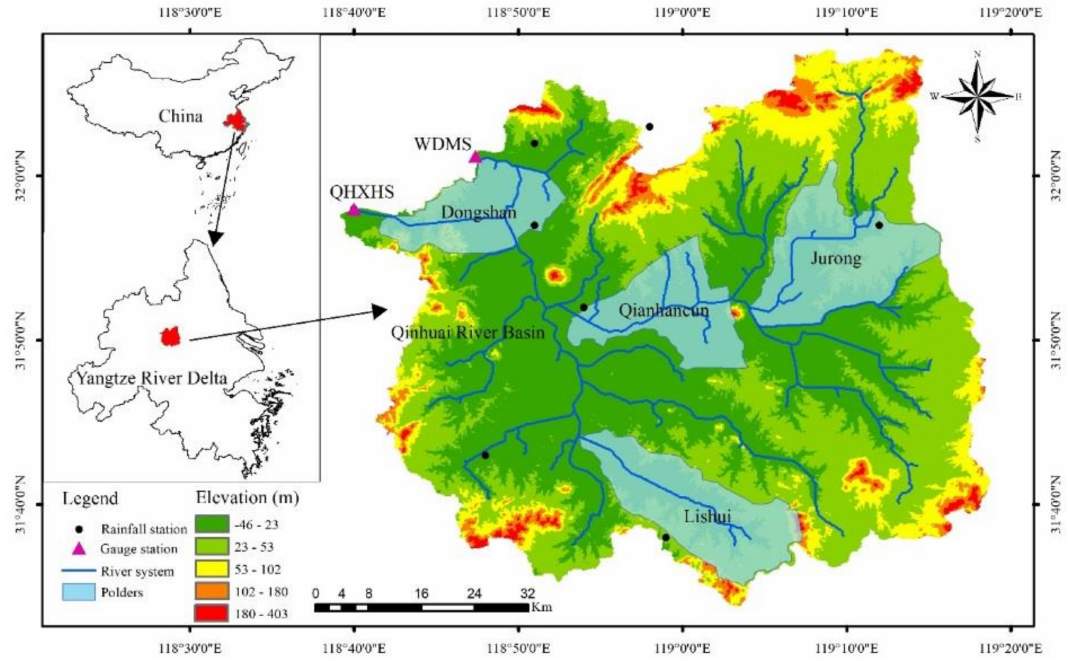
Figure 1. Location of the study area, distribution of urban agglomeration polders, and rainfall and gauge